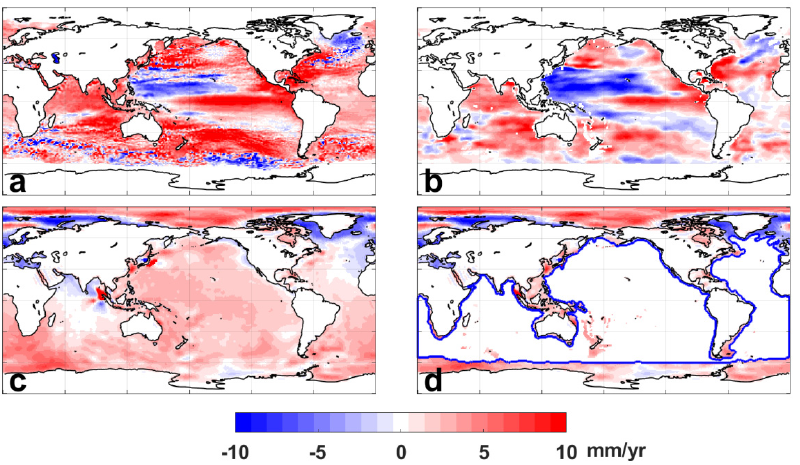
Figure 1. Trend maps of ( a ) altimetry data provided from CMEMS, ( b ) Argo steric data from JAMSTEC, and ( c ) GRACE CSR Mascons (GAD included after considering IB correction). ( d ) Trend map of CSR Mascons outside ocean domain D (cid:48) , whose outer boundary is indicated by a thick blue line. Area D (cid:48) is commonly available for all data sets considered in this study (altimetry data from CMEMS, CCI, CSIRO, and JPL; Argo steric data from IPRC, JAMSTEC, and SIO; and GRACE Mascon solutions from CSR, JPL, and GSFC). The trends are estimated by using linear regression after removing seasonal variations. Table 1. Trend estimates of all data sets used in this study with respect to ocean domains. Maximum data coverages of individual data sets are used to yield estimates in the third column, and the ensemble mean values (bolded numbers) are used for Figure 2.Results in the fourth column are consistently estimated over the common data coverage D (cid:48) defined in this study, with the plots shown in Figure 3. Estimates of ∆ A and ∆ M consider GIA correction using the same model of ICE6G-D. The trends are estimated by using linear regression after removing seasonal variations. Error boundaries are given at 95% confidence